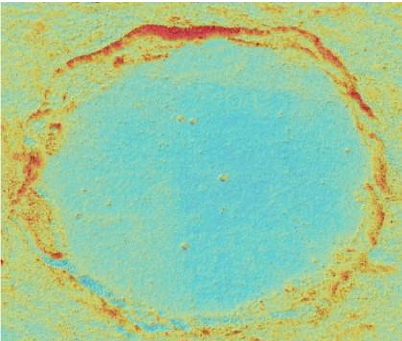
Figure 2. DEM Height rendering images of the tail of Montes Jura southeast (up) and Crater Plato (down) 2.2.2 Root-mean-square